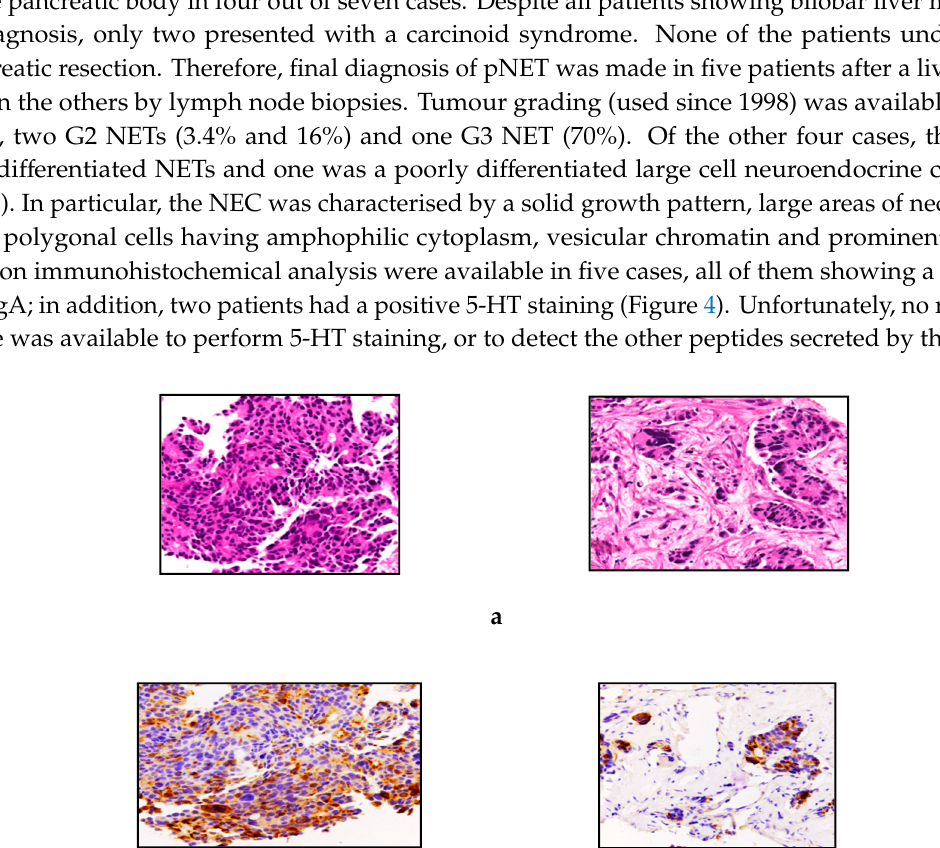
Table 2. Pathological findings and follow-up in patients with serotonin-secreting pancreatic NETs. N o.